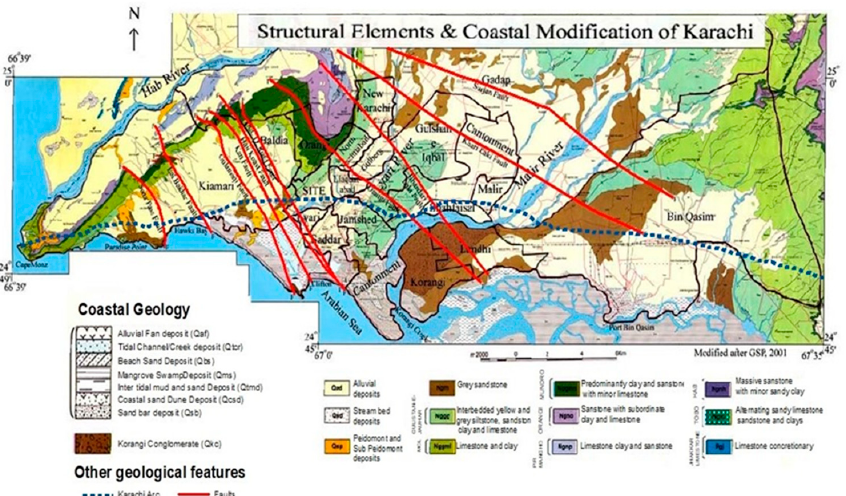
Figure 9. Fault lines (red lines) and Karachi Arc (thick dotted blue line) overlaid on the Geological Map of Karachi. Karachi Arc appears to be creeping eastward, which is directly related to active subsidence of the Hyderabad graben that underlies it (Source: [27,43]).